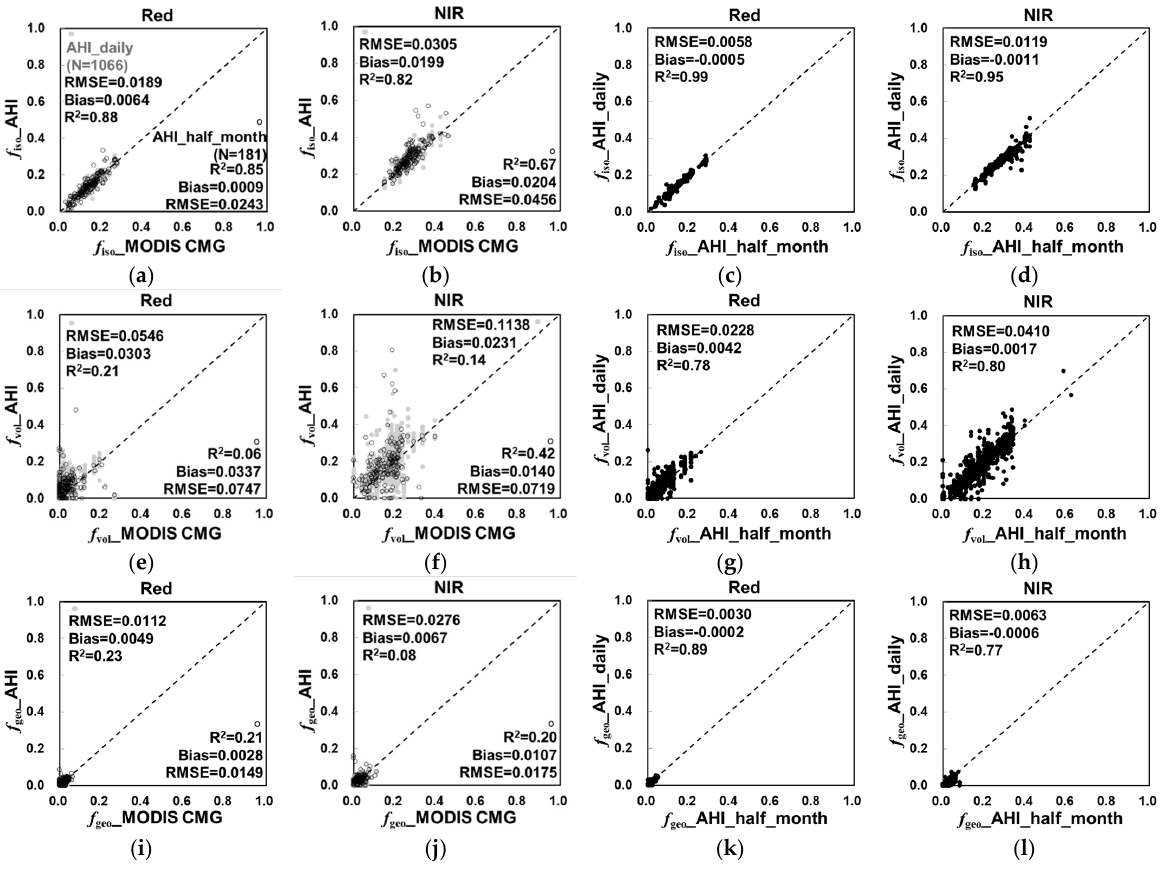
Figure 9. Comparisons of BRDF parameters that were retrieved from AHI- and MODIS CMG- accumulated observations during a day and half a month. ( a ) refers to comparisons of f iso that was retrieved from half-month (black circle) and daily (grey dot) AHI data with those from half-month MODIS data in the red band, and ( b ) is similar to ( a ) but in the NIR band. ( c , d ) refer to comparisons of f iso that were retrieved from the AHI data between the half-month scale and daily scale in the red and NIR bands, respectively. ( e – h ) refer to the results similar to ( a – d ) but for f vol , and ( i – l ) are those for f geo